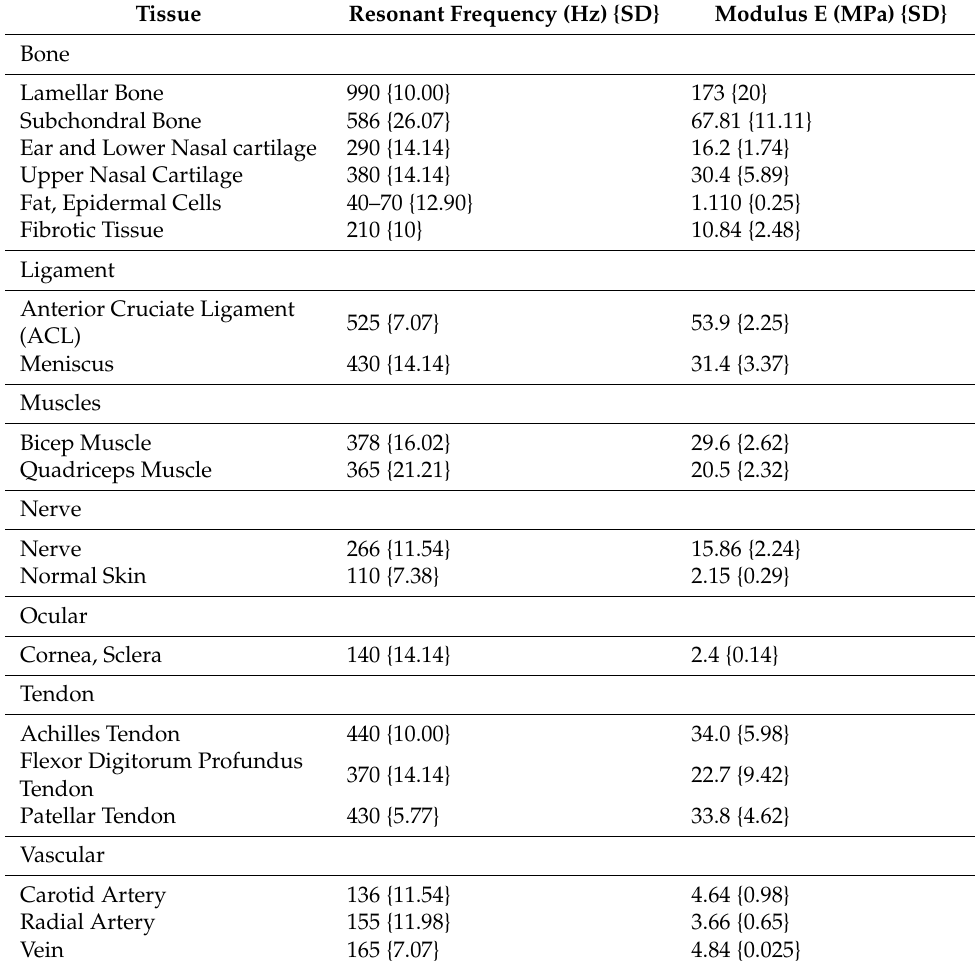
Table 1. Assignment of Resonant Frequency Peaks and Associated Moduli Based on VOCT Measurements